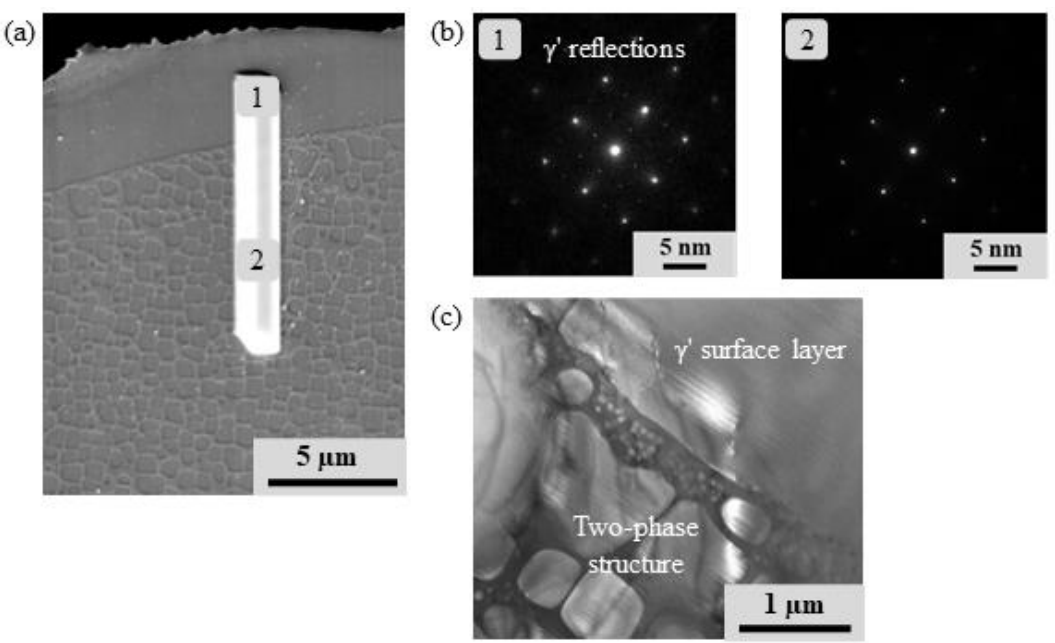
Figure 4. TEM lamella preparation and TEM analysis: ( a ) position of TEM lamella prepared with focused ion beam; ( b ) TEM diffraction patterns in the surface layer (area 1) and the two-phase structure; ( c ) dark field image with γ′ reflection of the transition area.